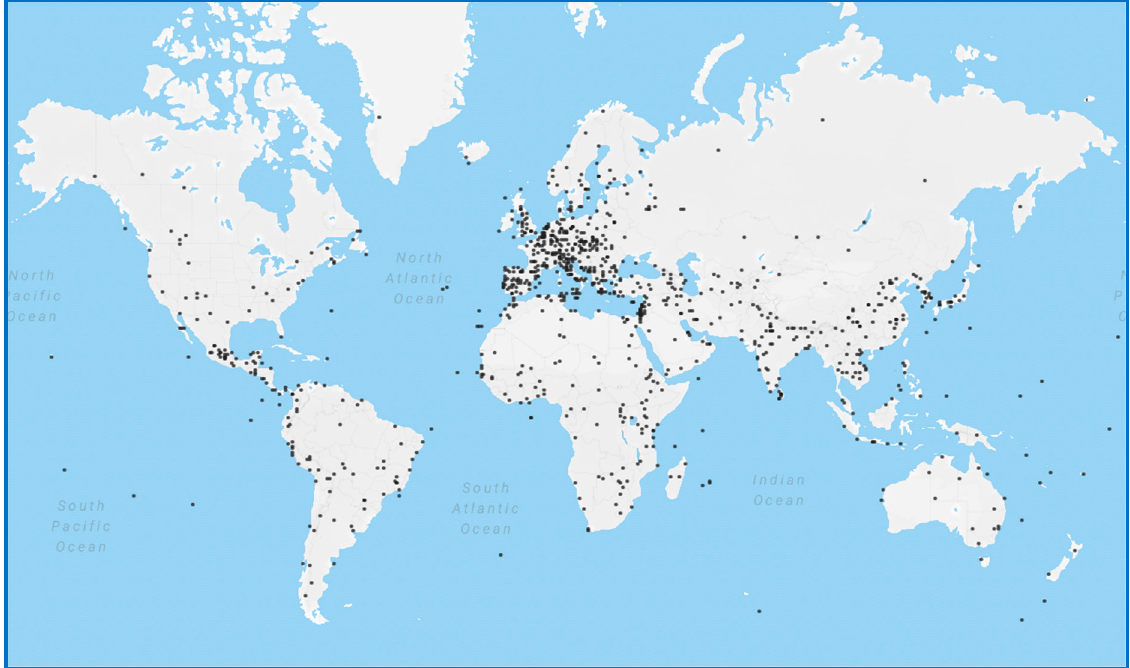
Figure 9. Global locations of World Heritage Sites (http://whc.unesco.org/en/list) (accessed on 17 January 2022).